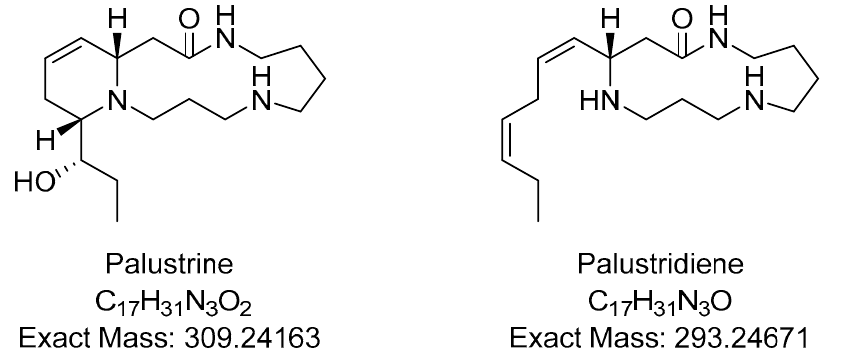
Figure 1. Structures of known Equisetum alkaloids [13].